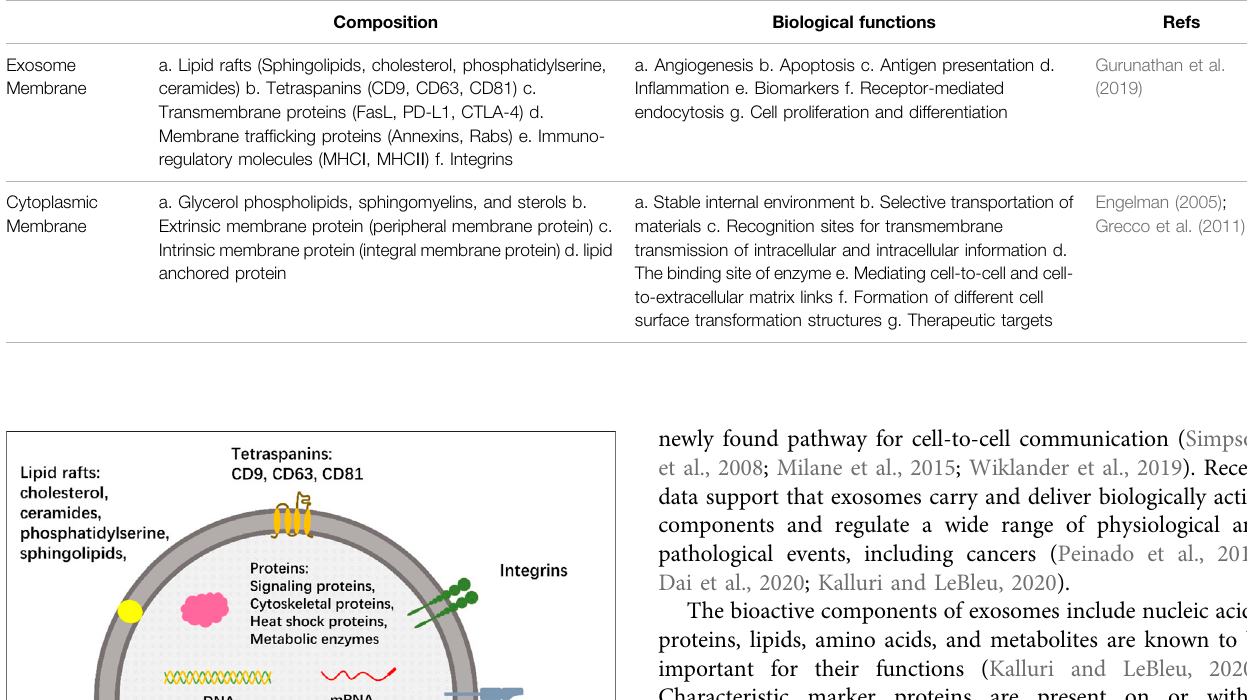
TABLE 1 | Comparison of exosome membrane and cytoplasmic membrane.